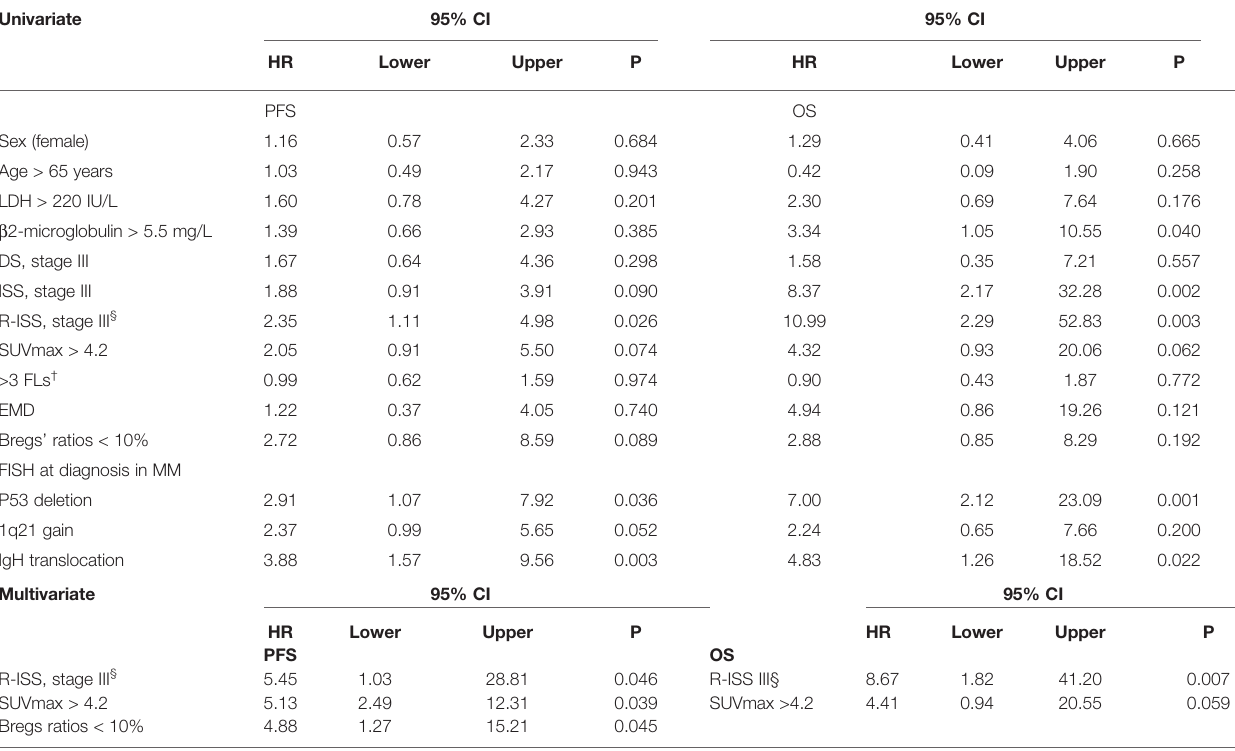
TABLE 2 | Univariate and multivariate analysis of PFS and OS according to baseline risk variables for myeloma. Univariate 95% CI 95% CI Lower Upper Lower Upper